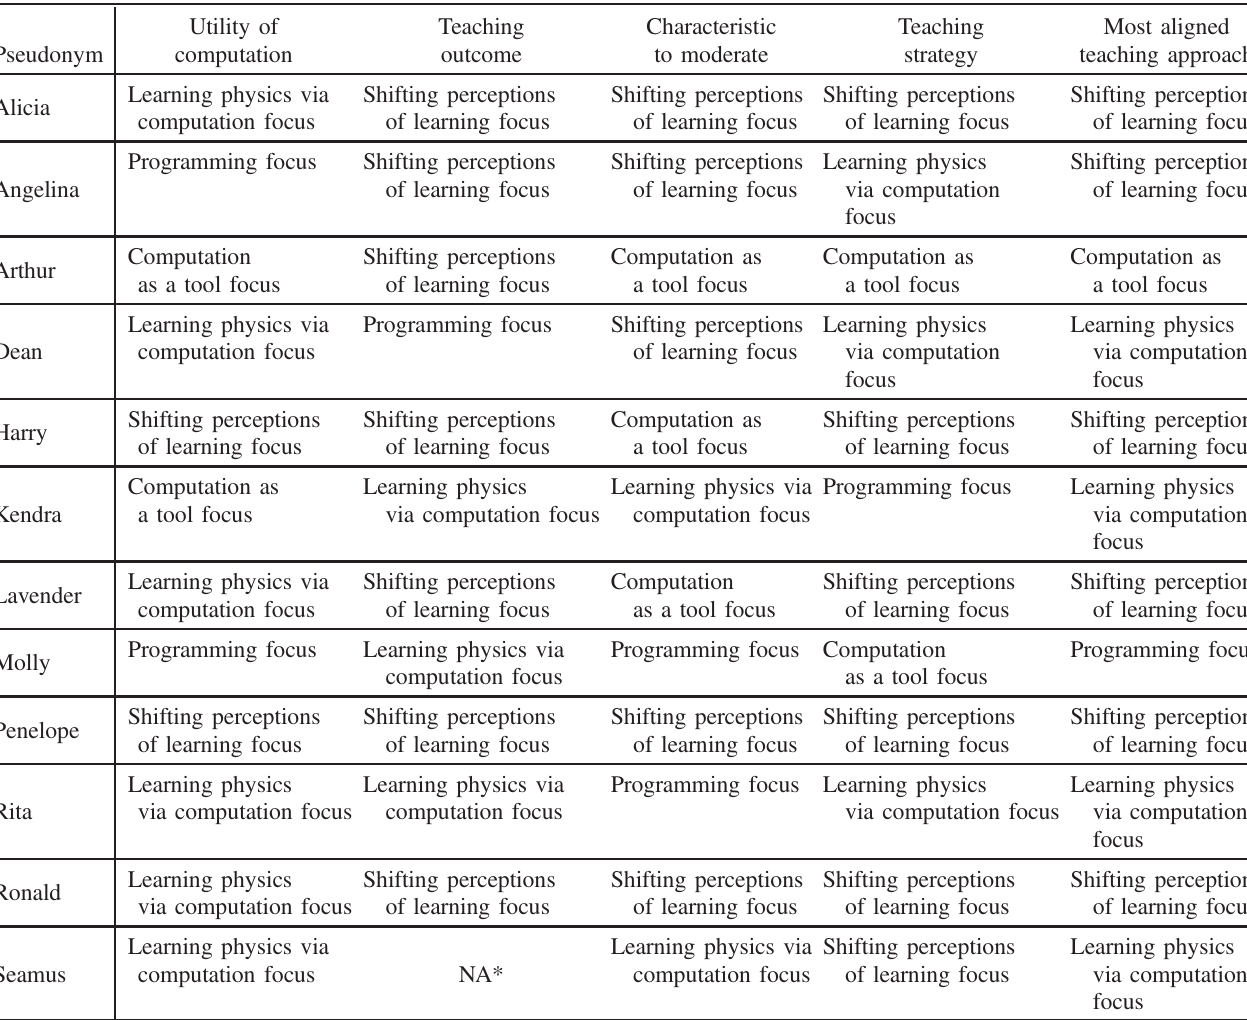
TABLE XIV. Description of each learning assistant ’ s teaching approach. Columns 2 – 5 indicate with which teaching approach the variation they displayed in each theme was associated. For example, in the utility of computation theme, the majority of Alicia ’ s comments fell under the computation aids content learning variation. This is the variation associated with the teaching approach of learning physics via computation focus, and so she is indicated as being aligned with learning physics via computation focus in the utility of computation theme. Column 6 indicates which teaching approach each learning assistant is most aligned with overall, given their alignment along each of the four themes. *Seamus did not discuss any of the teaching outcome variations used in our analysis, and so he is given no assignment along that